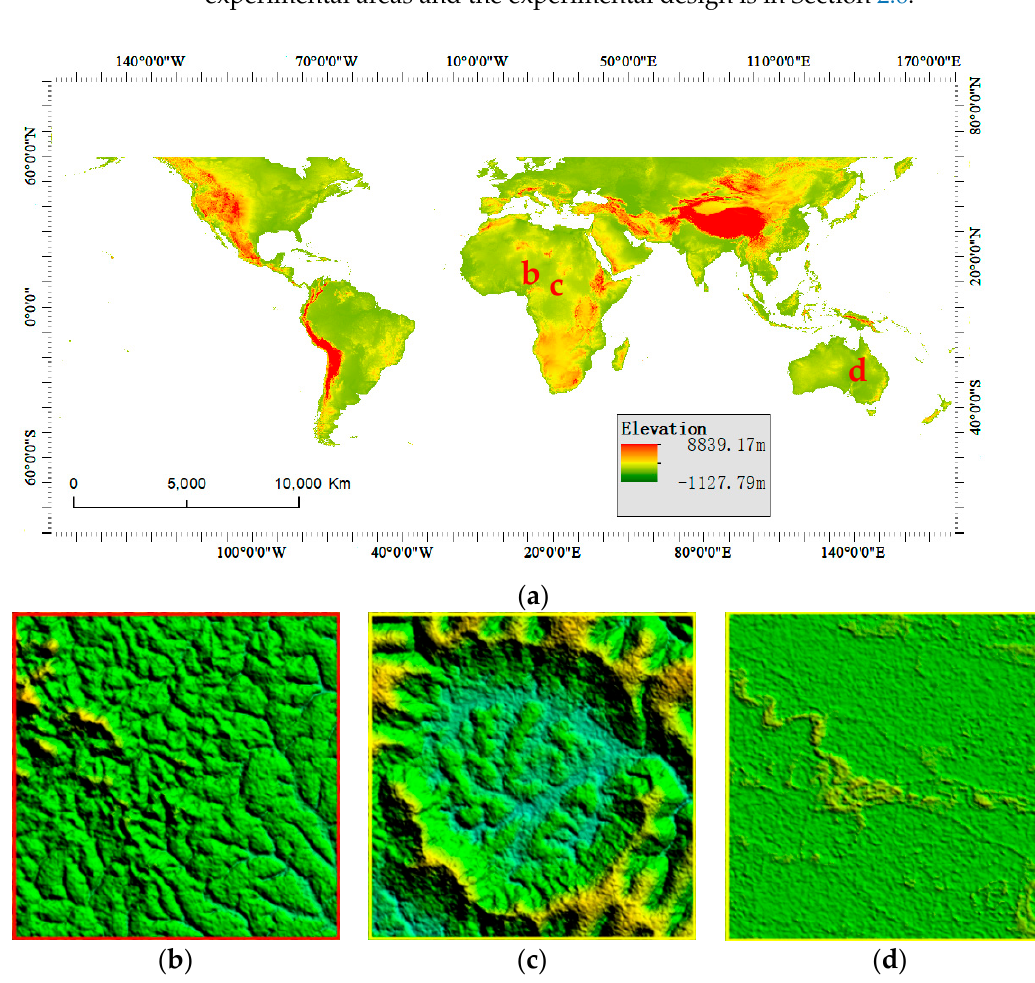
Figure 2. SRTM 1 data and the terrain of some experimental areas. ( a ) SRTM 1. Local enlargement of ( b ) area b, ( c ) area c, ( d ) area d marked by the corresponding letters in the figure.